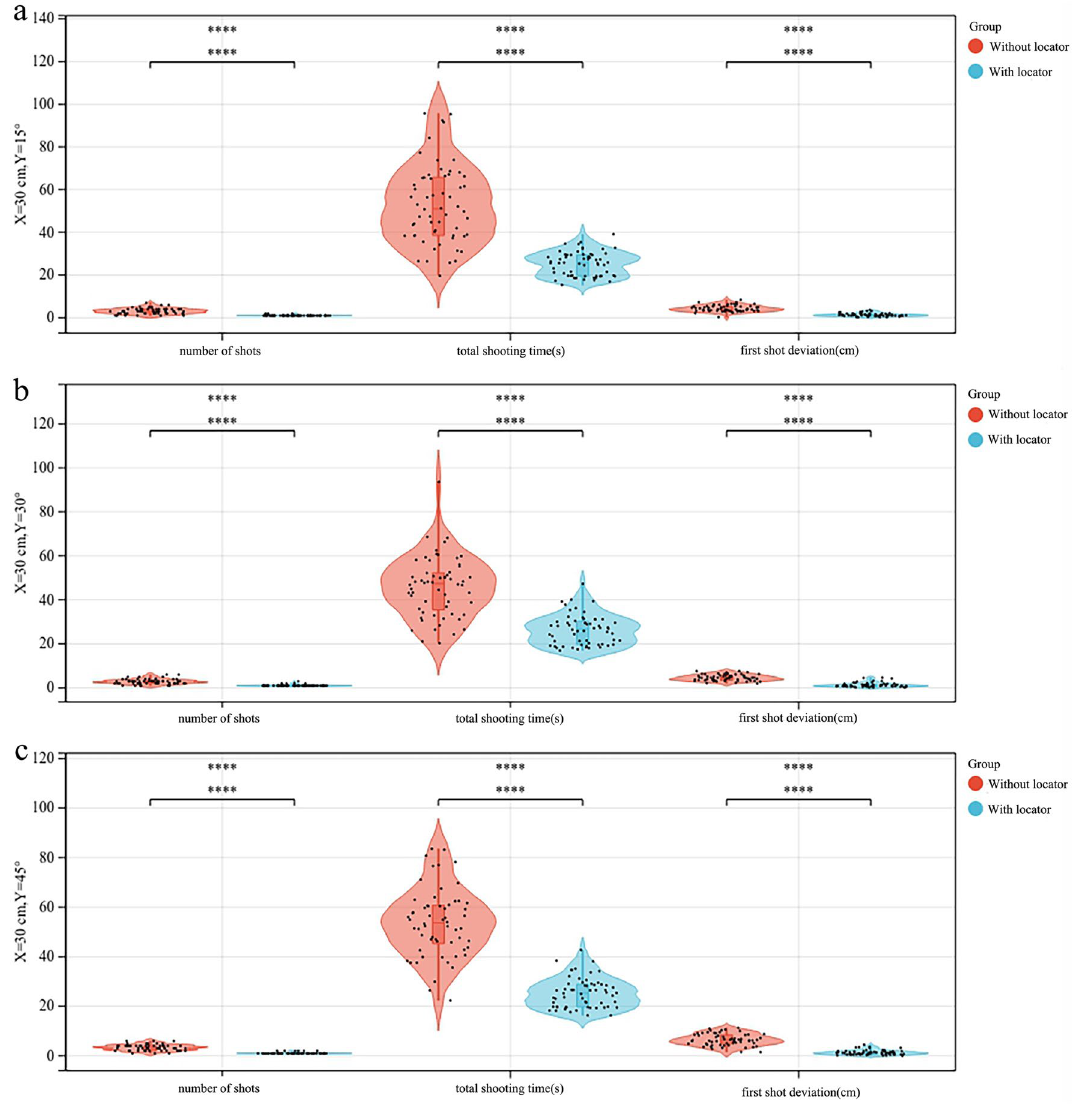
Figure 4. Comparison of the number of shots, total shooting time, and first-shot deviation between the control and experimental groups. ( a ) when X = 30 cm and Y = 15°, ( b ) when X = 30 cm and Y = 30°, ( c ) when X = 30 cm and Y =